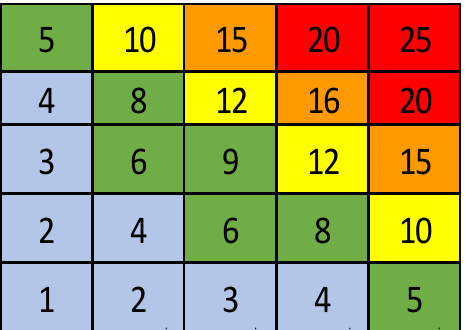
Figure 2. Global Performance Index matrix (the colors order blue-green-yellow-orange-red means an increasing GPI value and consequently a decreasing Performance value).